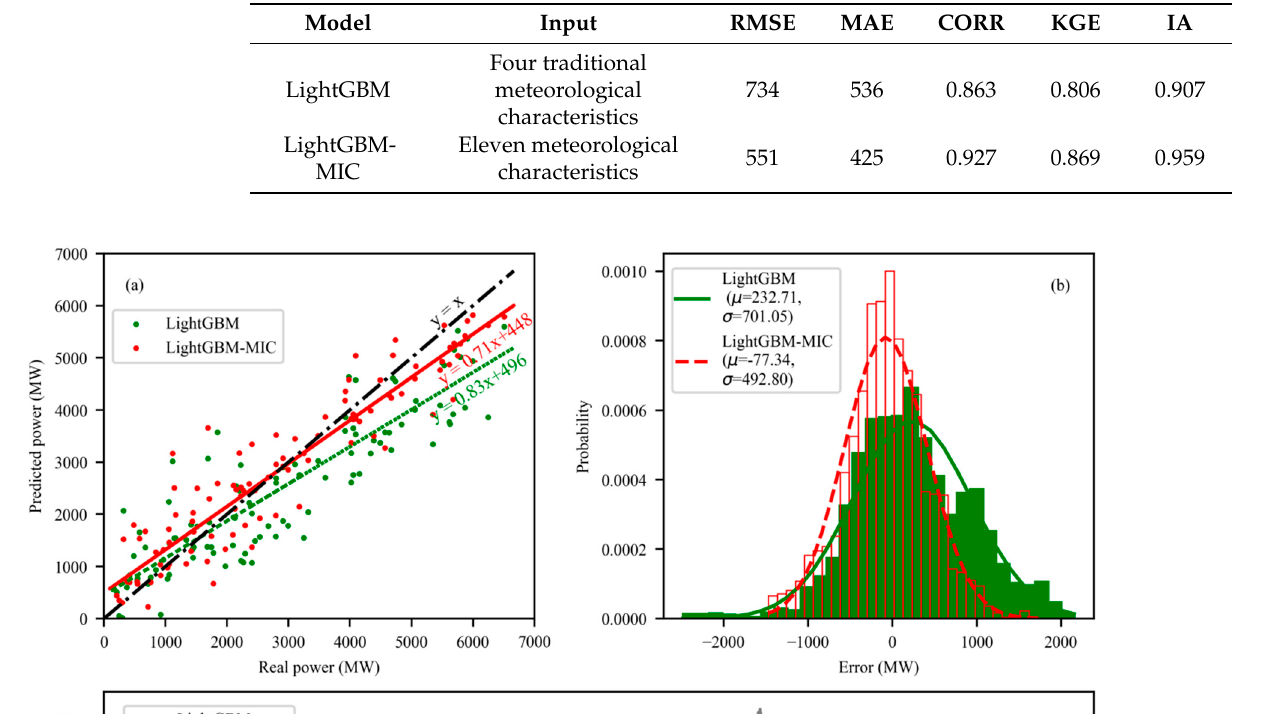
Table 7. Comparison of prediction accuracy of different meteorological characteristics.